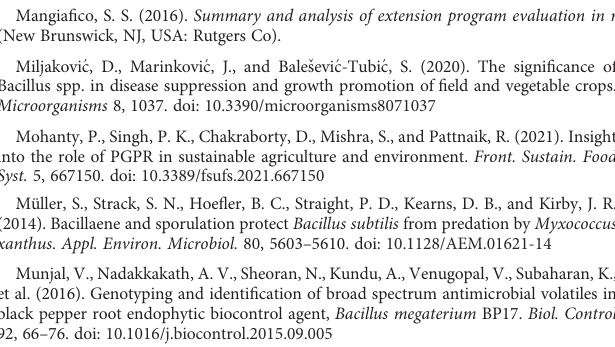
Figueredo, M. S., Tonelli, M. L., Iba ́ ñez, F., Morla, F., Cerioni, G., Tordable, M. C., et al. (2017). Induced systemic resistance and symbiotic performance of peanut plants challenged with fungal pathogens and co-inoculated with the biocontrol agent Bacillus sp. CHEP5 and Bradyrhizobium sp. SEMIA6144. Microbiological Res. 197, 65 – 73. doi: 10.1016/j.micres.2017.01.002 Figueredo, M. S., Tonelli, M. L., Taurian, T., Angelini, J., Ibañez, F., Valetti, L., et al. (2014). Interrelationships between Bacillus sp. CHEP5 and Bradyrhizobium